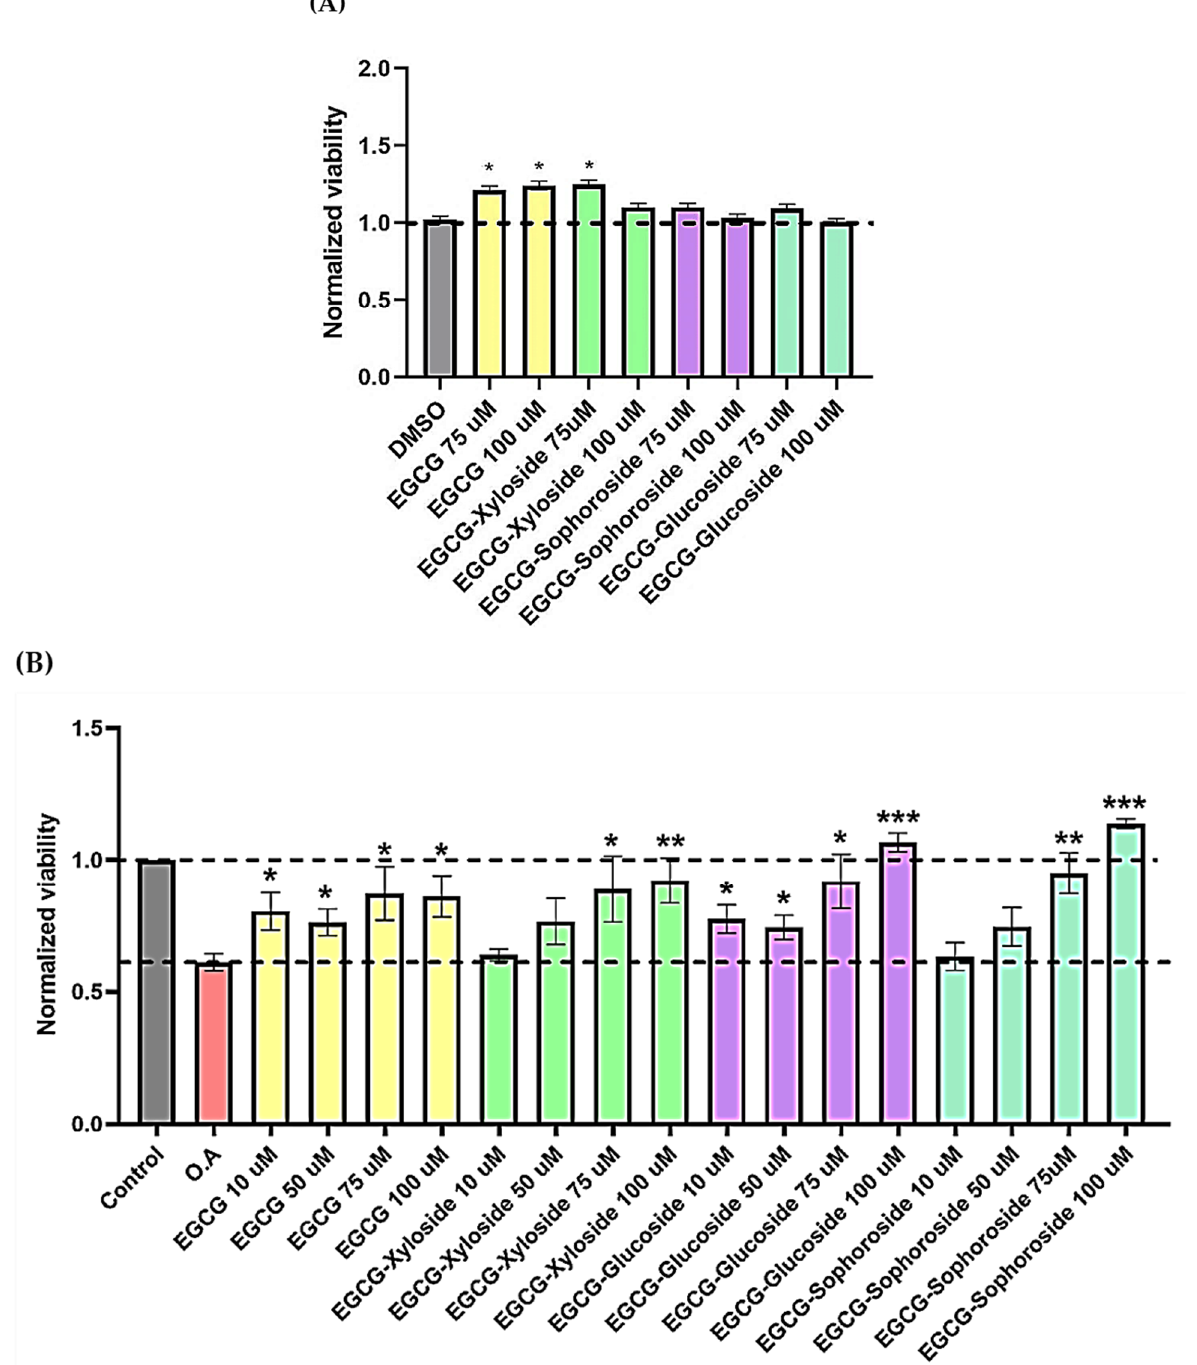
Figure 6. ( A ) Cell viability of SH-SY5Y cells after exposure to EGCG and its glycosides (75 and 100 µ M). An MTT assay was used to determine cell viability 24 h after cells treatment. Each data point represents the mean ± SEM of two replications in three different experiments. * p < 0.05 vs. vehicle-treated cells. ( B ) Neuroprotective effect of EGCG derivatives using the OA-induced neurodegeneration model. SH-SY5Y cells were treated for 1 h with the compounds, at the concentrations indicated, prior the addition of OA. The cells were then incubated for 24 h. Cell viability was measured by MTT test. Mean ± SEM of at least three independent experiments. * p < 0.1, ** p < 0.01, *** p < 0.001.